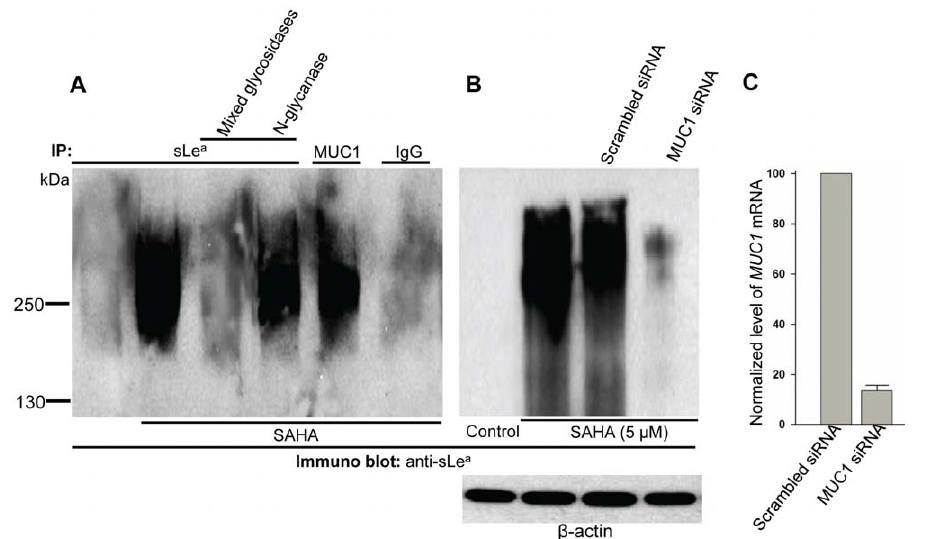
Figure 3. SLe a induced by SAHA in RWPE-1 cells is associated with O-glycans of MUC1. Anti-sLe a immunoprecipitates from the lysates of RWPE-1 cells treated with SAHA were digested with either mixed glycosidases (to remove sialic acid and O-glycans) or N-glycanase (which removes N- glycans) prior to western analysis for sLe a . (A) SLe a band in mixed glycosidase-treated samples were completely abolished while sLe a staining was retained after N-glycanase treatment. SLe a band was also detected in anti-MUC1 immunoprecipitate (MUC1 IP), indicating that sLe a is associated with MUC1. IgG lane served as a background control. (B) Anti-sLe a western blot of the lysates of cells treated with PBS, SAHA, SAHA plus scrambled RNAi, or SAHA plus MUC1 RNAi. (C) Relative expression level of MUC1 gene was determined according to D Ct method (see materials and methods) after normalization with GAPDH (=100%) and then expressed as % of MUC1 mRNA in the control (=100%) (n=3).